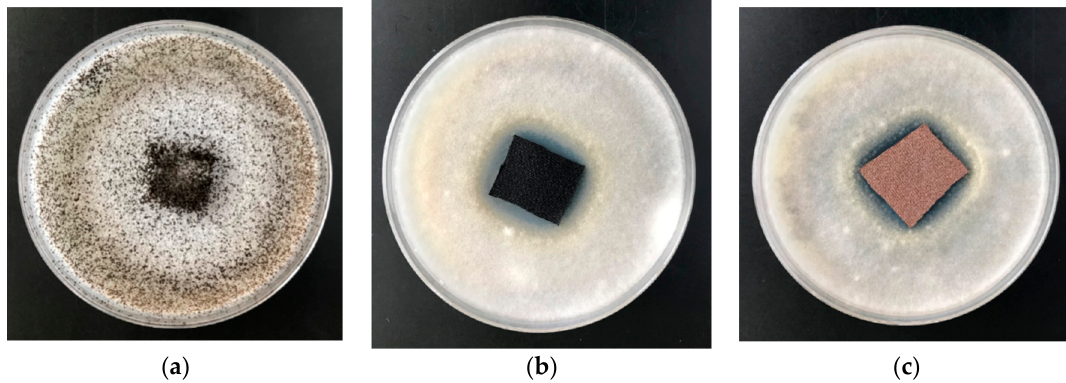
( c ) Figure 8. The PET samples coated with copper modifier antimicrobial activity tests . Inhibition zones of Escherichia coli bacterial growth on Petri dishes: ( a ) PETE, ( b ) PETE-Cu (0) -1; ( c ) PETE-Cu (0) -2. The similar pictures have been obtained for PETE and PETE-Cu (0) against Staphylococcus aureus species. The results of tests on the antibacterial activity of PETE-Cu (0) composites against Escherichia coli and Staphylococcus aureus are illustrated in Table 8. Table 8. Results of tests on the antibacterial activity of PETE-Cu (0) composites, procedure in accordance with the EN ISO 20645:2006. [119]. Sample Name 1 Concentration of inoculum (bacterial suspension) number of live bacteria: E. coli —CFU/mL = 1.2 × 108 and S. aureus —CFU/mL = 1.7 × 108. The results revealed strong visible inhibition zones of bacterial growth on Petri dishes (Figure 8), and therefore proved antimicrobial protection of metallized surface of PETE-Cu (0) against representative Gram-negative ( Escherichia coli ) and Gram-positive ( Staphylococcus aureus ) bacteria